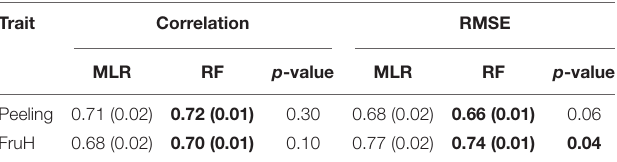
TABLE 2 | Prediction accuracy of multiple linear regression (MLR) and random forest (RF).